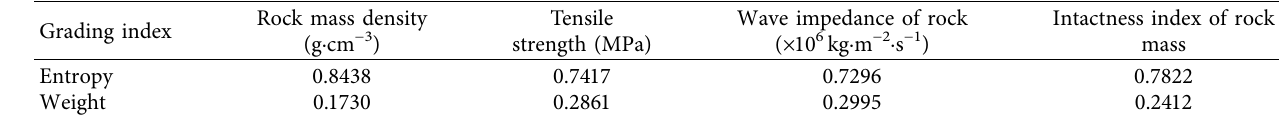
Table 6: Entropy and weight obtained by EWM.